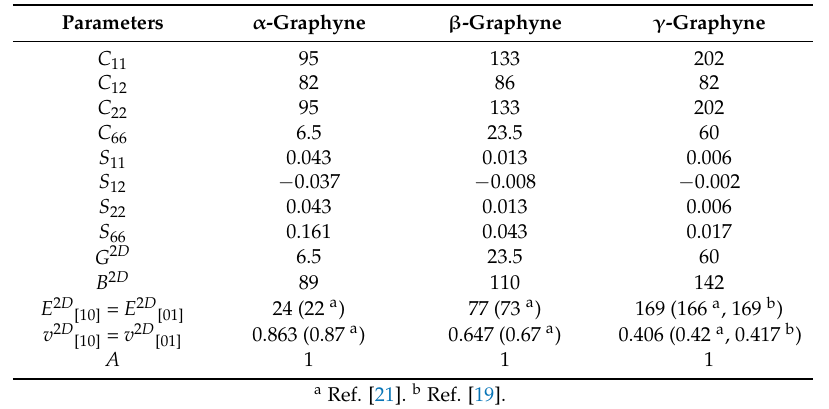
Table 2. Graphyne ( α , β , γ ): elastic constants C ij , shear modulus G 2 D elastic modulus B 2 D ,